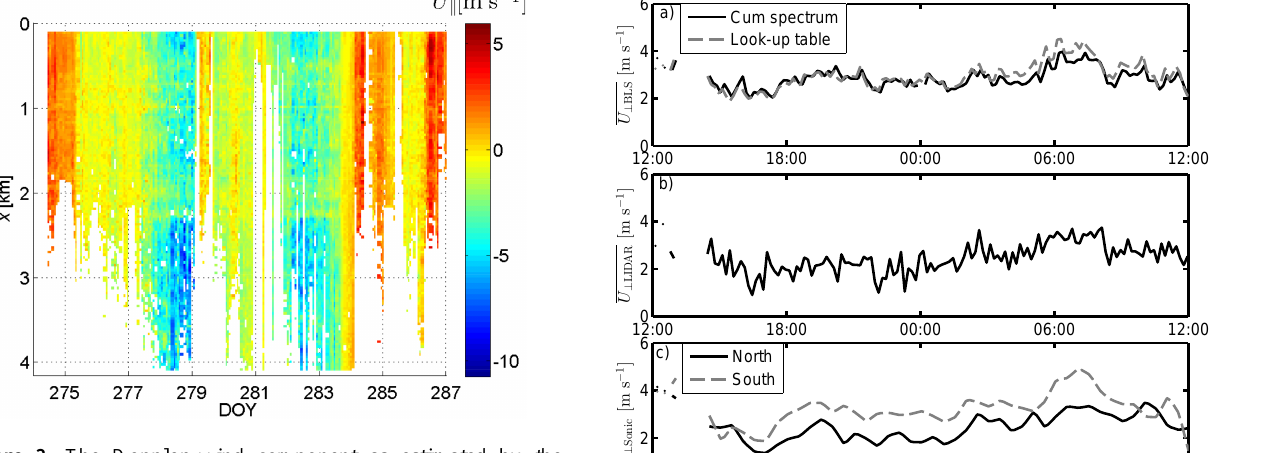
Figure 3. The Doppler wind component as estimated by the Doppler lidar beam of 174 ◦ , with lidar beam distance (resolution of 30m) and time (resolution of 10min).